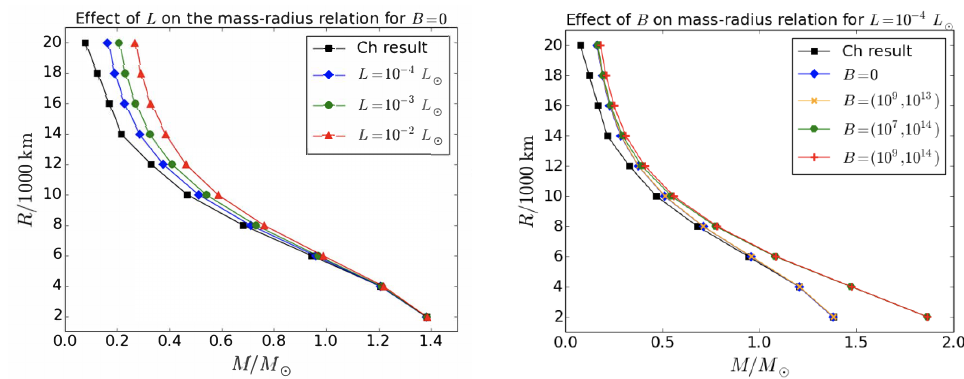
Figure 4. Left panel: The effect of L on the mass–radius relation of non-magnetised WDs is shown for L = 10 − 4 L (cid:12) (blue diamonds), L = 10 − 3 L (cid:12) (green circles) and L = 10 − 2 L (cid:12) (red triangles), along with the Chandrasekhar result (black squares). Right panel: The effect of field strength on the mass–radius relation of B-WDs is shown for B = ( B s , B 0 ) = ( 0,0 ) (blue diamonds), B = ( 10 9 ,10 13 ) G (orange crosses), B = ( 10 7 ,10 14 ) G (green circles) and B = ( 10 9 ,10 14 ) G (red pluses), along with the Chandrasekhar result (black squares) for L = 10 − 4 L (cid:12) . See